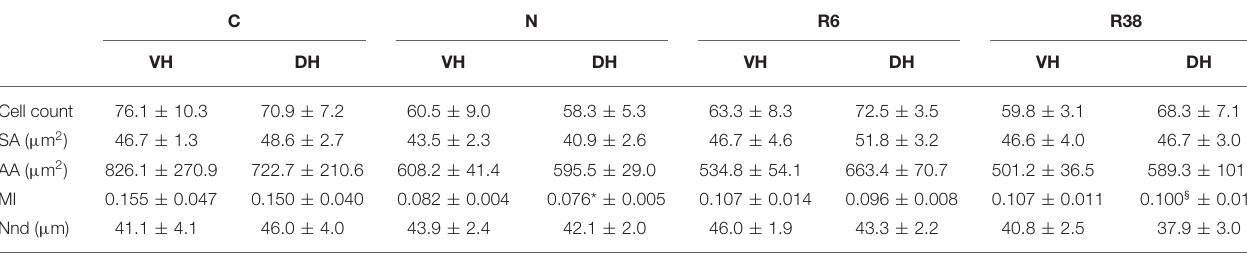
TABLE 2 | Microglia